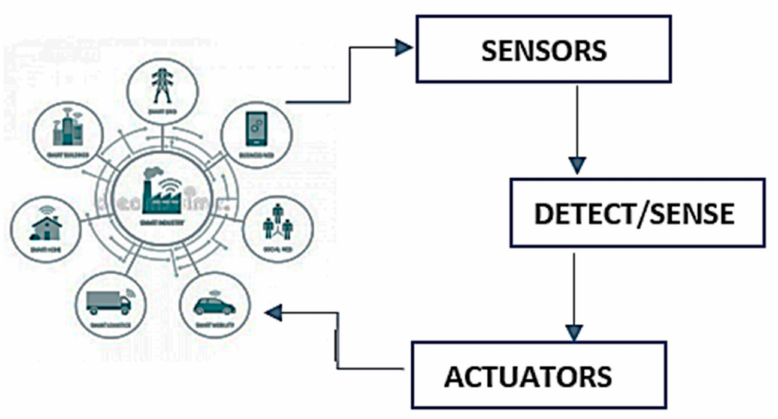
Figure 5. The role of MCC computing in mobile and IoT